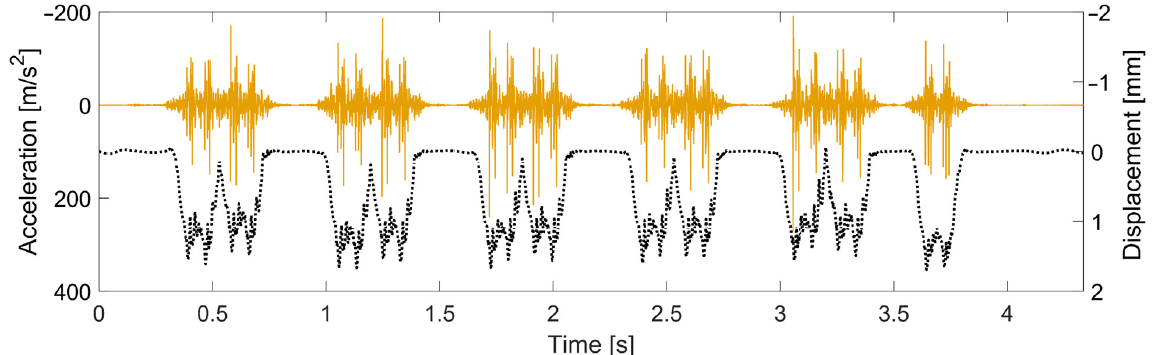
Figure 6. Example of acceleration recording (continuous line) and reconstructed displacement (dotted line).